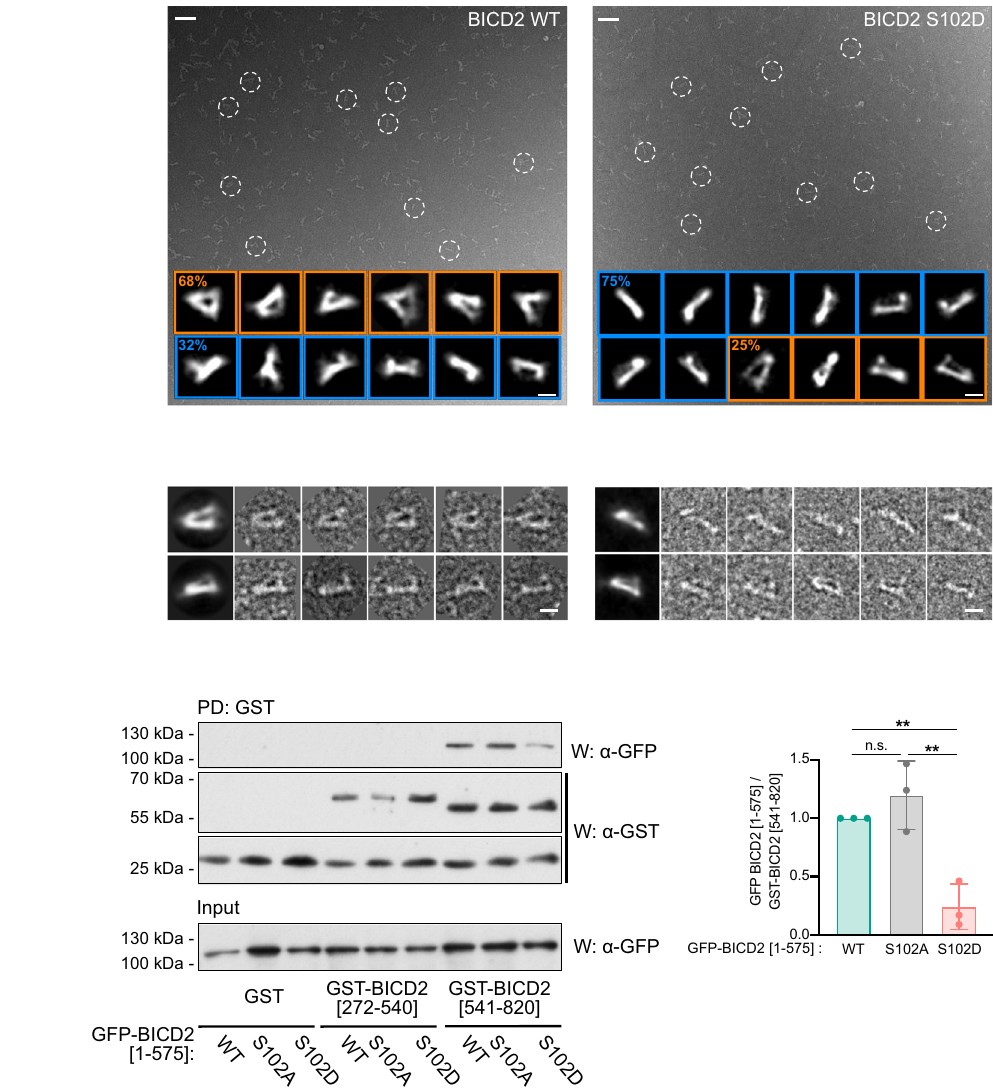
Fig. 4 | Modi fi cation of Ser102 alters the conformation of BICD2. A Representative electron micrographs obtained for wild type ( left ) and S102D ( right ) TwinStrep-BICD2, using negatively stained samples. Several BICD2 indivi- dual molecules are highlighted within white dashed circles. Representative 2D averageimagesaredisplayedatthebottomofeachmicrograph.Thepercentageof particles with a triangular or a rod-like morphology is noted in each case (30,476 BICD2 wild-type particles and 22,021 BICD2 S102D particles). Scale bars for micrographs and individual/average images represent 50 and 10nm respectively. B Gallery of representative individual images of the wild type (left) and S102D (right)TwinStrep-BICD2plusthecorrespondingaverageimages.Scalebars,10nm. A and B Show results from one out of three experiments with identical results, in which 195 micrographies were acquired for BICD2 WT and 165 for BICD2 S102D. A representative image fi eld is shown for each BICD2 form in ( A ). C Modi fi cation of